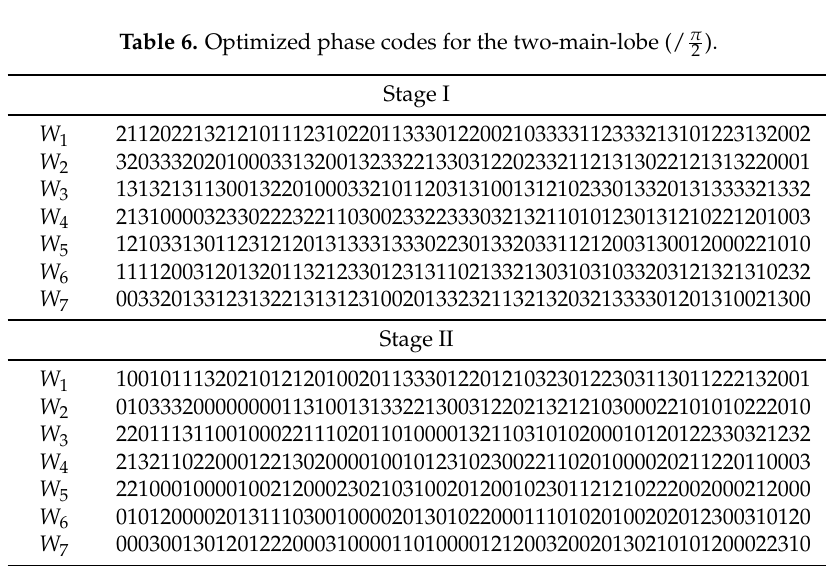
Table 6. Optimized phase codes for the two-main-lobe (/ π